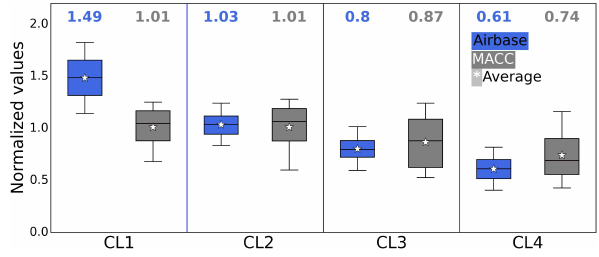
Figure 15. Percentiles (5–25–50–75–95) of ozone weekly ampli- tudes in clusters; Airbase vs. MACC, first CA. Upper values indi- cate the mean weekly amplitude of each cluster.